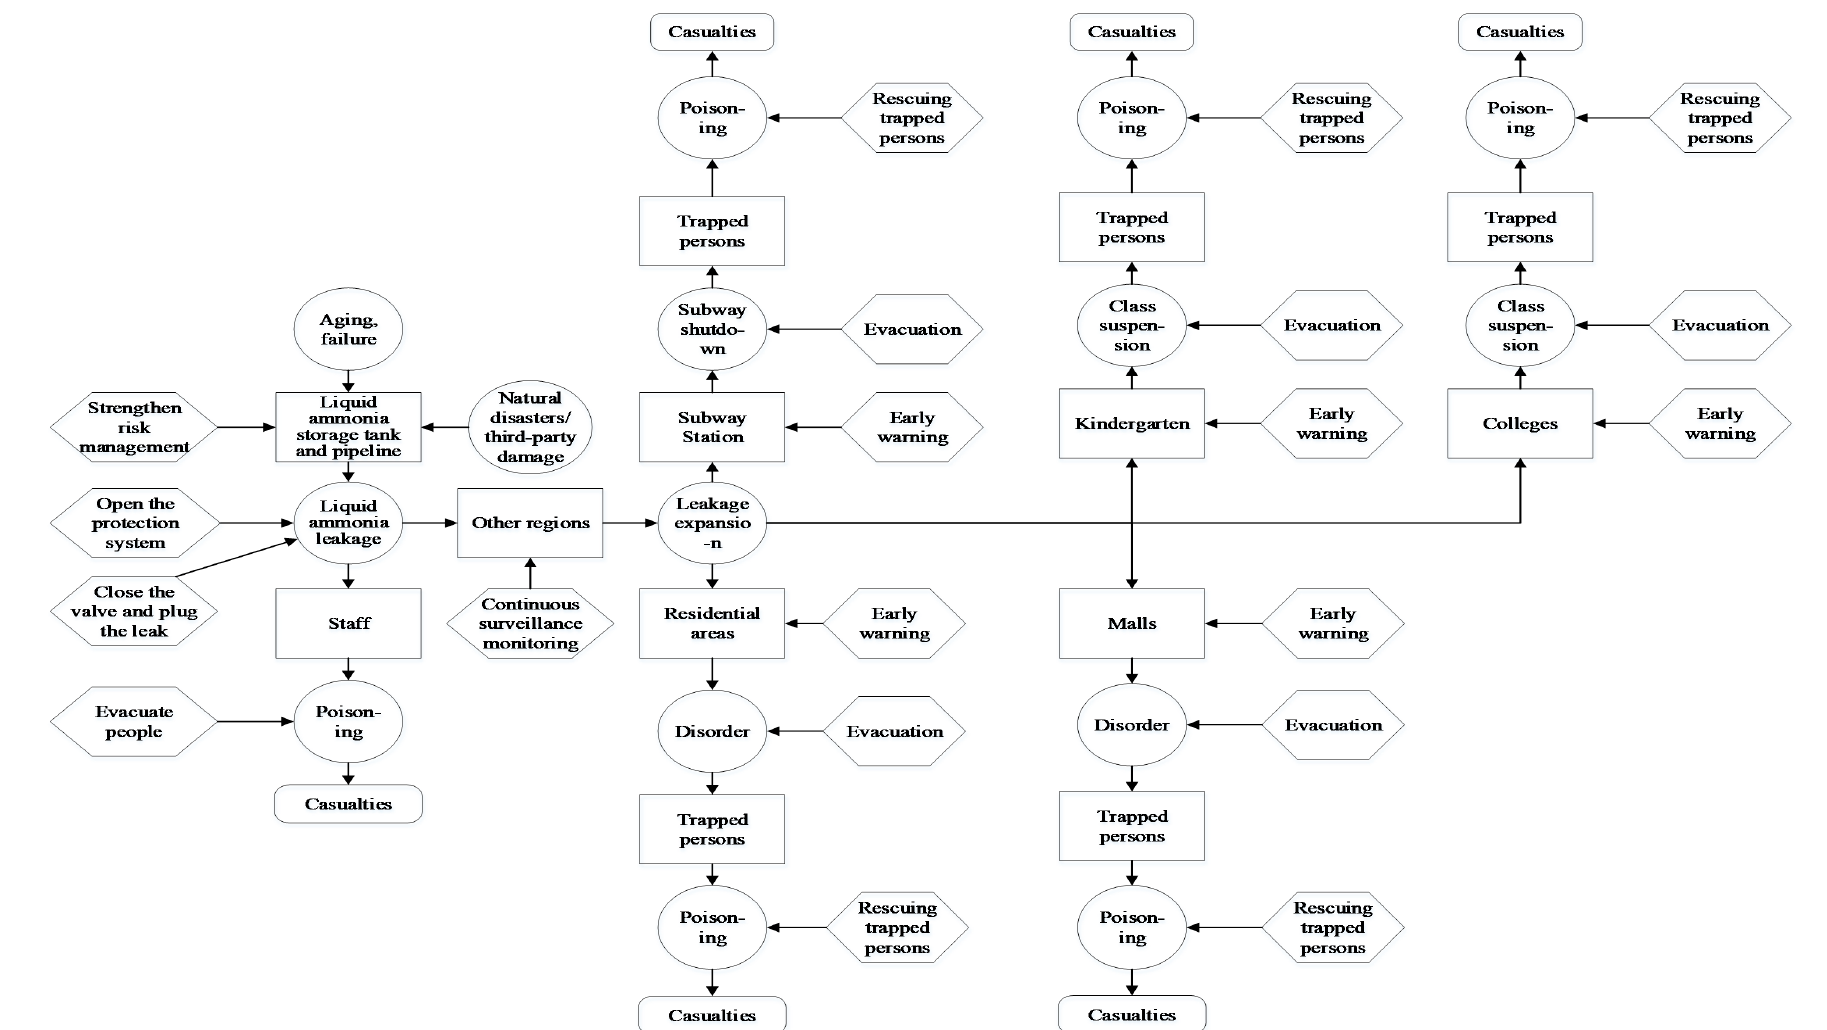
Figure 2. Liquid ammonia leakage full scenario evolution flow